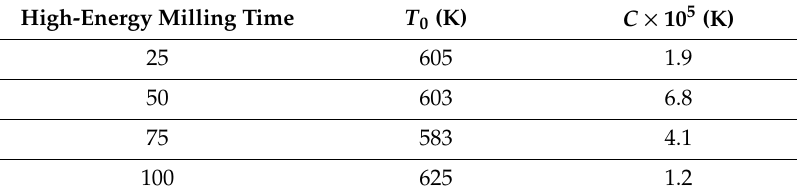
Figure 7. Inverse dielectric permittivity at 10 kHz as function of temperature for ceramics obtained from 25 h ( a ) and 100 h ( b ) milled powders (symbols: experimental data; solid line: fitting to Curie–Weiss law). Table 3. Curie–Weiss temperature T 0 , Curie–Weiss constant C , and di ff useness parameter γ for KNN ceramics at 10